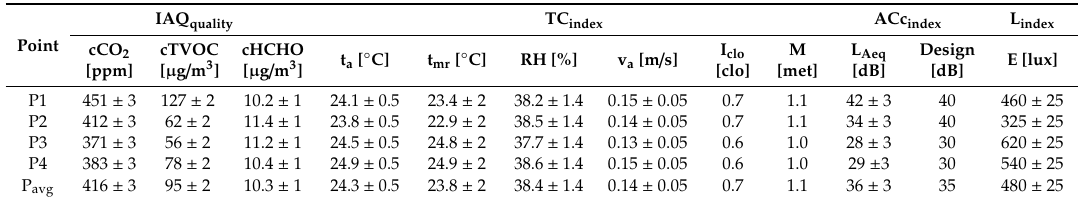
Table 7. Results of measured indoor parameters (inputs to IEQ sub-components calculation) in four locations (P1–P4) and mean value P AVG (weighed by using the locations by the floor area).